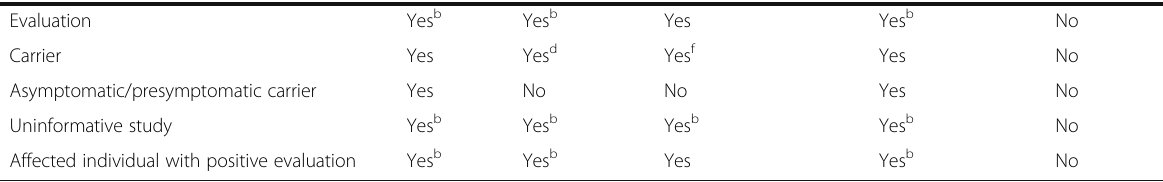
Table 2 Comparison of the pedigree symbols used (Continued) Evaluation